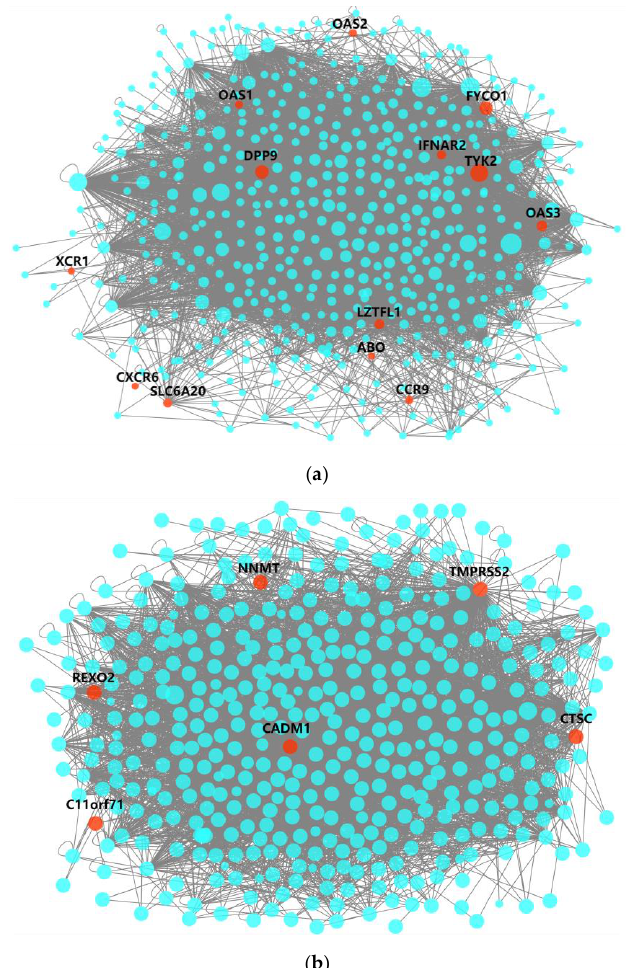
Figure 2. ( a ) Network of SCRGs in the European population with first neighbors. ( b ) Network of SCRGs in the Chinese population with first neighbors. The red nodes represent SCRGs, and the labels represent the gene symbols. The node size represents the degree of gene. The SCRGs in the European and Chinese populations include several hub nodes.